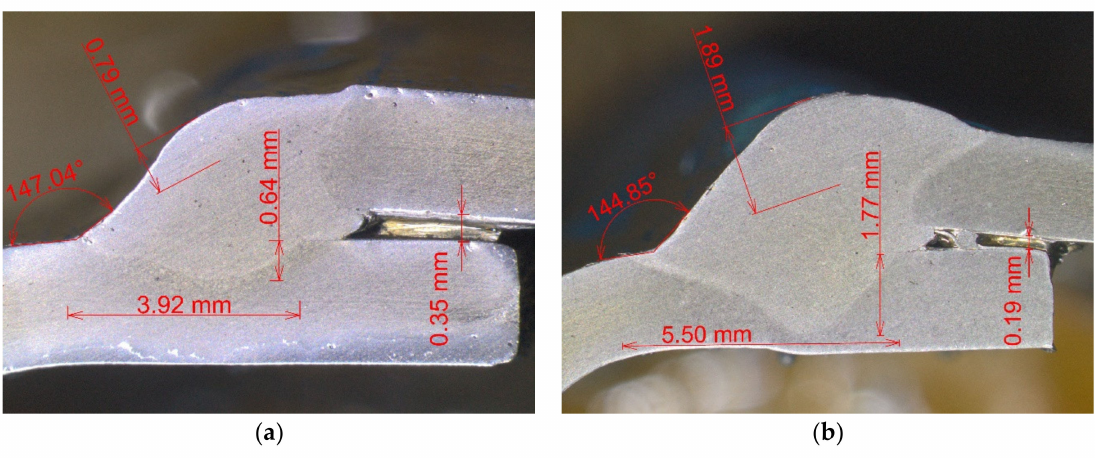
Figure 7. Weld cut: ( a ) Welding parameters I = 160 A, v = 70 cm · min − 1 ; ( b ) welding parameters I = 200A, v = 50 cm · min − 1 . The total deviation of the component (against 3D model, measured on a Romer Absolute Arm device) before and after welding are shown in Figures 8 and 9. The colour map represents the spatial deformation, and the dimension is